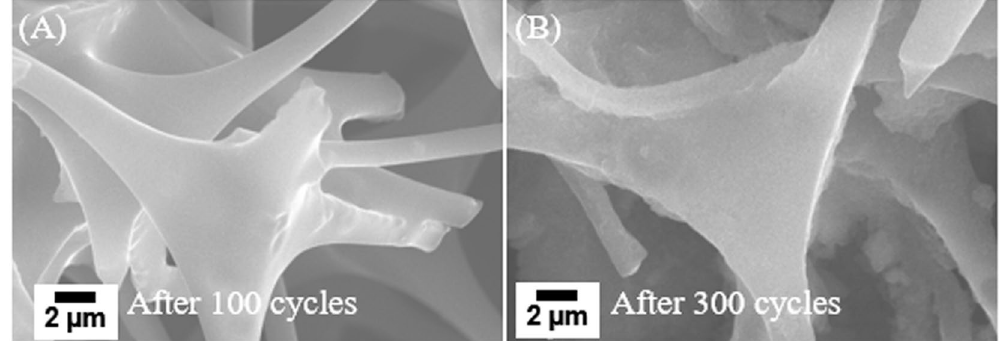
Figure 8. SEM images of the ECF electrode after ( A ) 100 and ( B ) 300 cycles at 0.1 A/g,